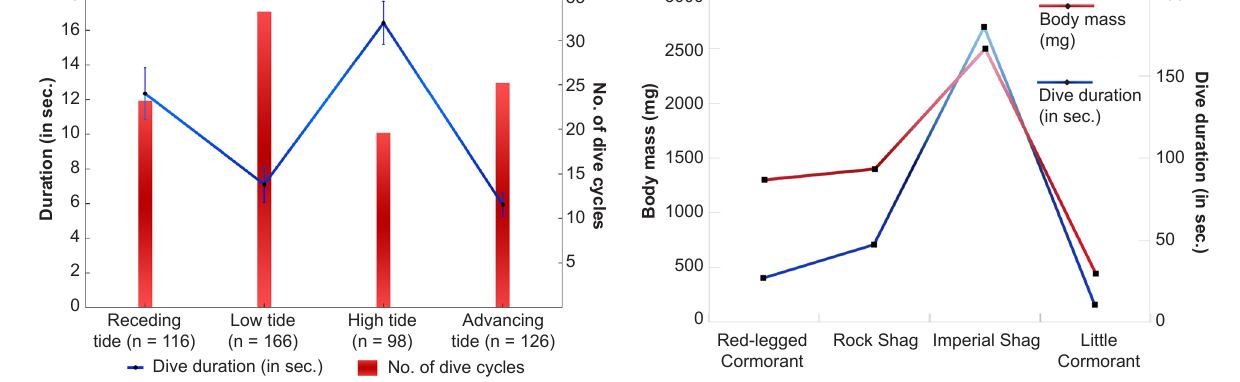
Figure 3. Relationship between dive duration and body mass of cormorants.